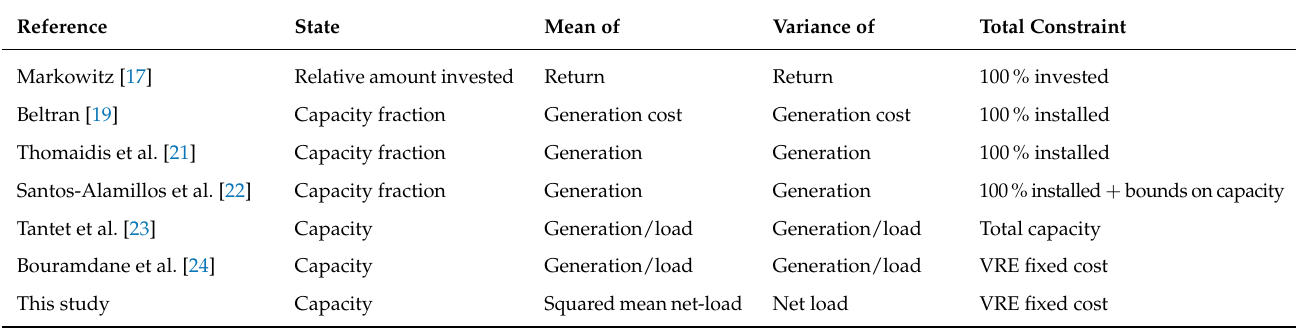
Table 2. Summary of the defining elements of Markowitz’ original portfolio theory and of some mean-variance analysis applications to the energy